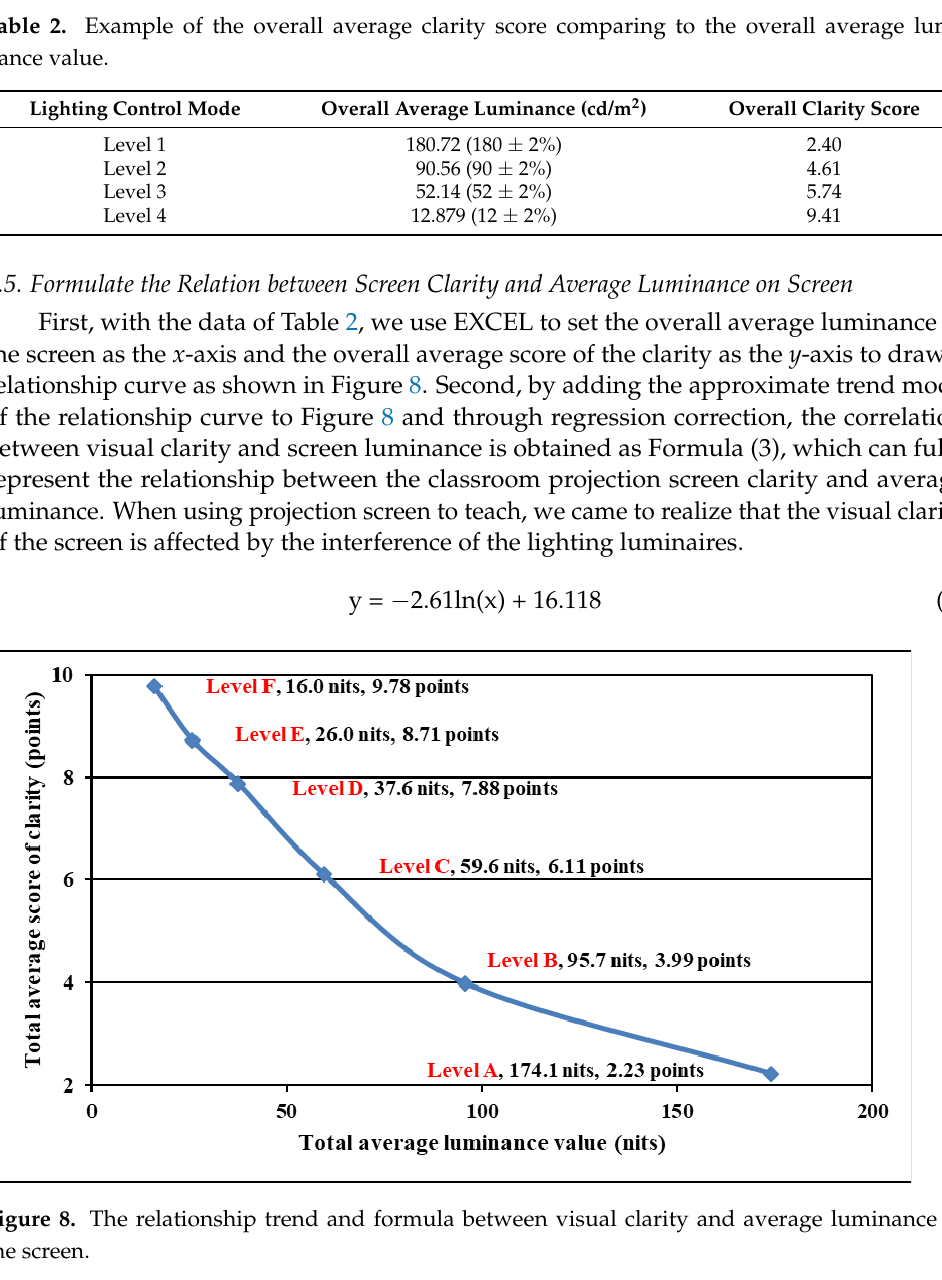
Table 3. Using clarity degrees to calculate average luminance. y = − 2.61ln(x) + 16.118